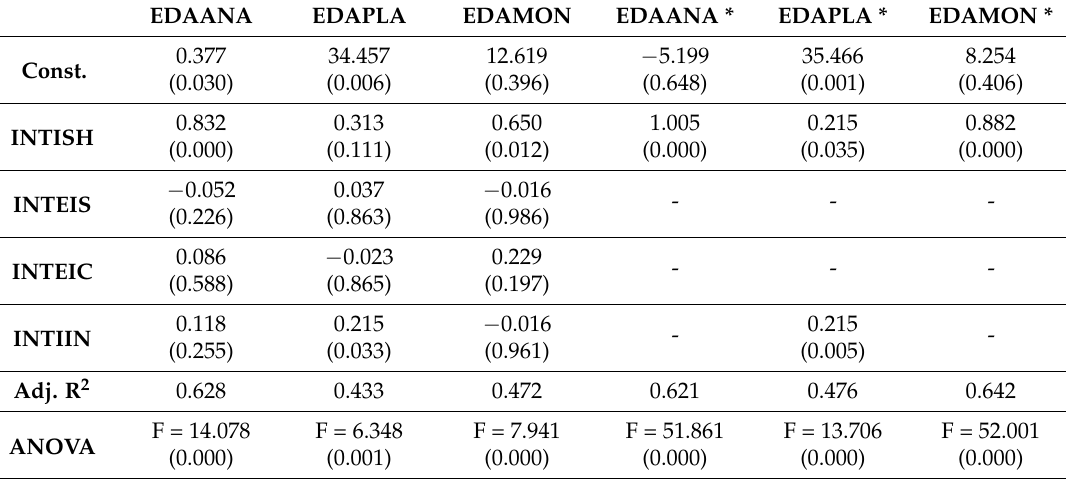
Table A1. Analysis for factors of 4PL Solutions